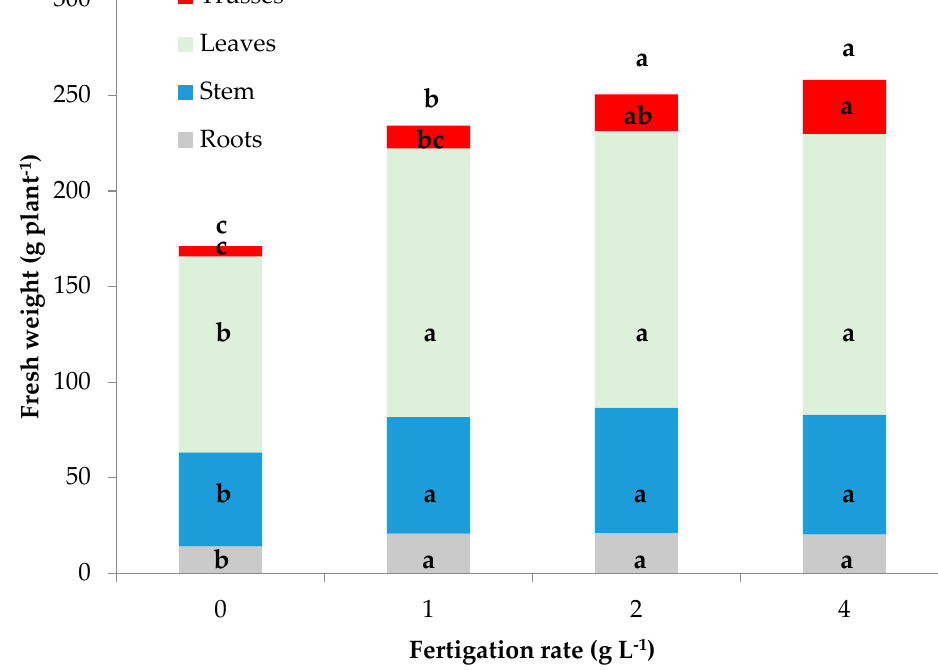
Figure 9. Effect of the nursery fertigation rates (g L − 1 of NPK 20-20-20) on the total, root, stem, leaves, and trusses fresh biomass of Solanum lycopersicum ‘Marmande’ plants grown in soilless cultivation (bars of the same color with different letters are significantly different at p < 0.05 according to the LSD test).